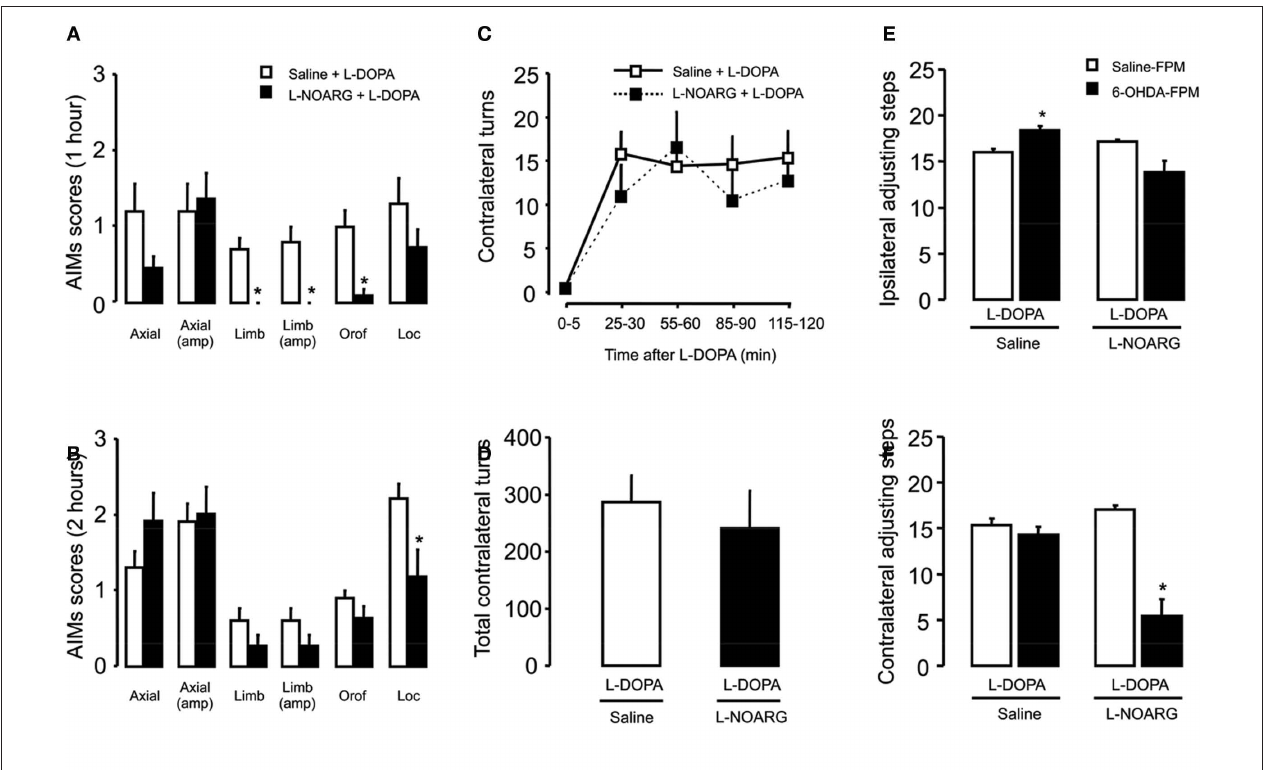
contralateral turns, assessed during 120 min after l -DOPA treatment. p > 0.05 (t-test) (e) l -DOPA treatment slightly increased the number of the adjusting steps of 6-OHDA-lesioned rats in the paw ipsilateral to the lesion. (F) l -DOPA treatment completely restored the akinesia in the contralateral-to lesion paw, of 6-OHDA- lesioned rats but l -NOARG pre-treatment impaired l -DOPA effect. * p < 0.05 vs Saline-FPM injected (two way ANOVA). Values are expressed as mean ± SEM (6-OHDA-FPM, n = 10–11/group; Saline-FPM, n